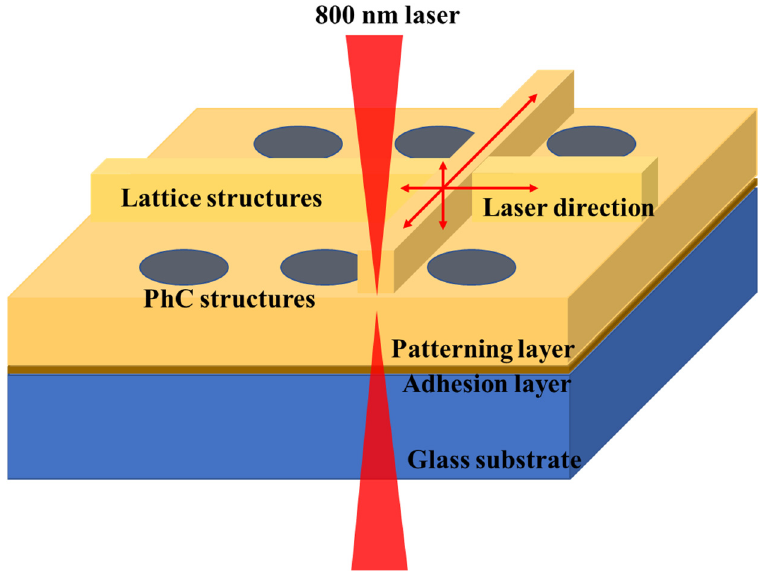
Figure 2. Second exposure with using two-photon lithography setup for patterning lattice structures by 800 nm laser and moving a computer-controlled piezoelectric stage.